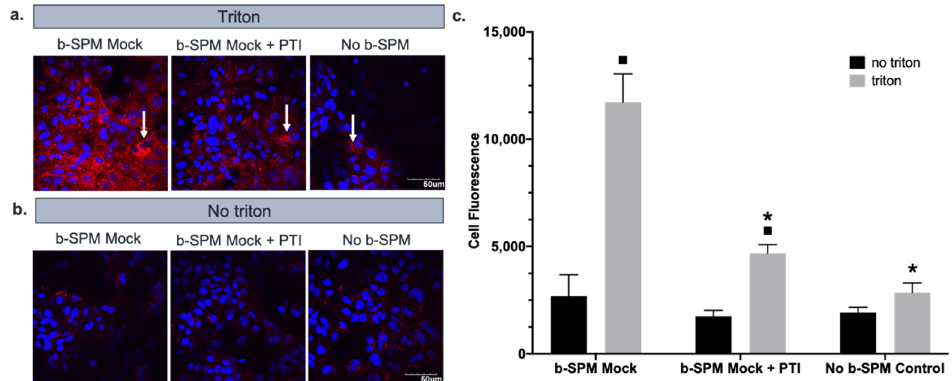
Figure 4. PTI significantly reduced the b-SPM uptake. Rho-avidin was used to visualize b-SPM (red), and DAPI was used to visualize the nuclei (blue). The presence of b-SPM presence is marked with the white arrows. ( a , b ) Qualitative representation of the data. Mock (only treated with HiPerFect) and mock + PTI astrocytes were exposed to 80 µ M of b-SPM and no b-SPM (PBS). No triton and no b-SPM samples were used as negative controls. Calibration bar is the same for all images (50 µ m). ( c ) Quantitative representation of the data ( n = 3/group). Asterisks (*) indicate a statistically significant difference ( p < 0.05) compared with the b-SPM mock triton group. Black squares ( (cid:4) ) indicate a statistically significant difference ( p < 0.05) between the no triton and the triton